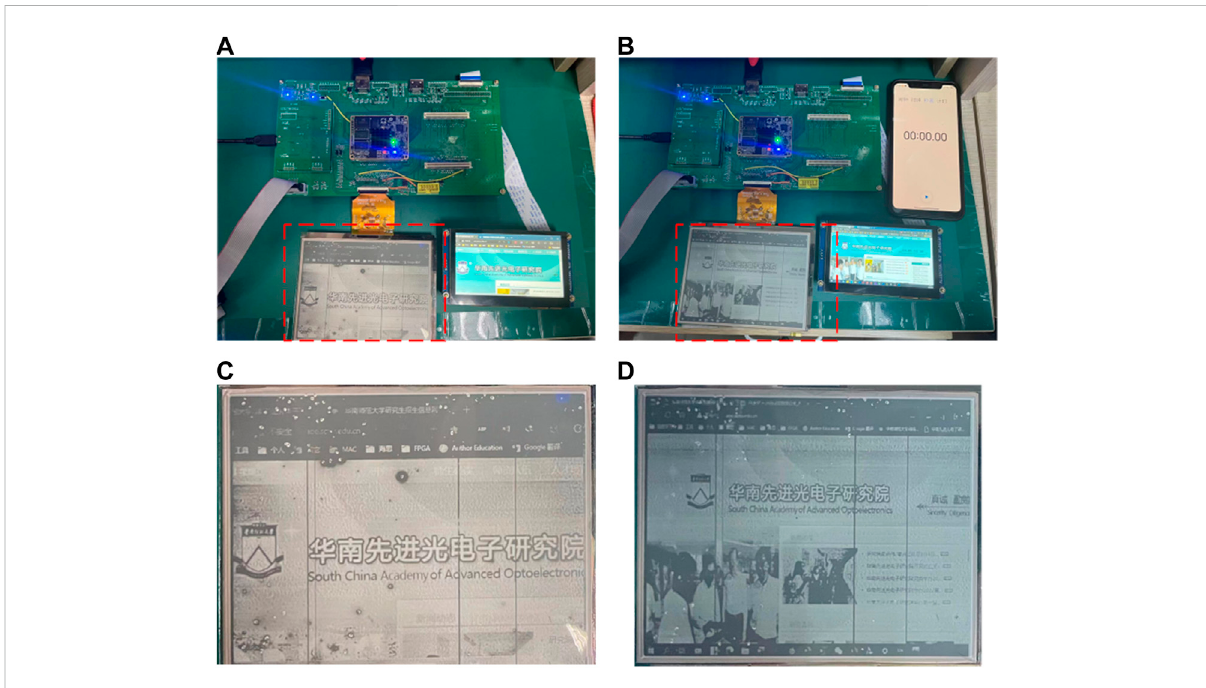
FIGURE 4 AnEWDindifferentmodes. (A) TheEWDinthecroppingmode. (B) TheEWDintheadaptiveresolutionmode. (C) Istheenlargeddetailof (A) . (D) Is the enlarged detail of (B) .